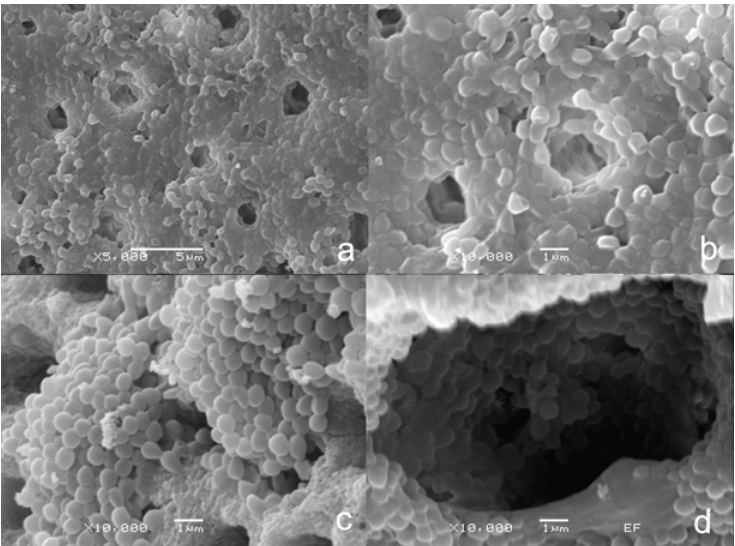
FIGURE 2- Scanning electron microscopy of (a) Root dentinal surface covered by E. faecalis biofilm (X5,000). (b) Magnification area of previous picture (X10,000). (c,d) Aggregated bacterial cells on and in dentinal tubules